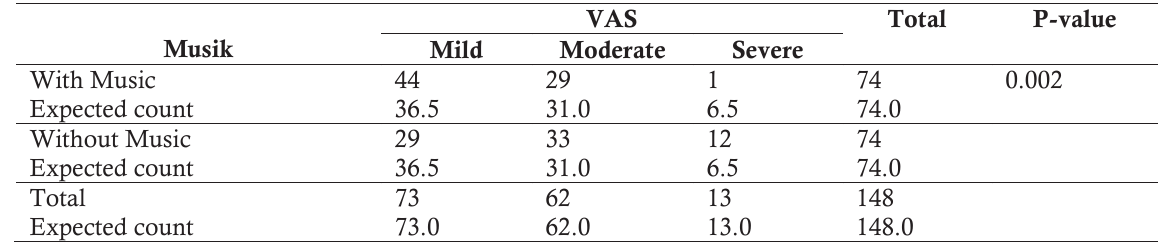
Table 1. Basic characteristics of sample and observation result after listening to Classical Music